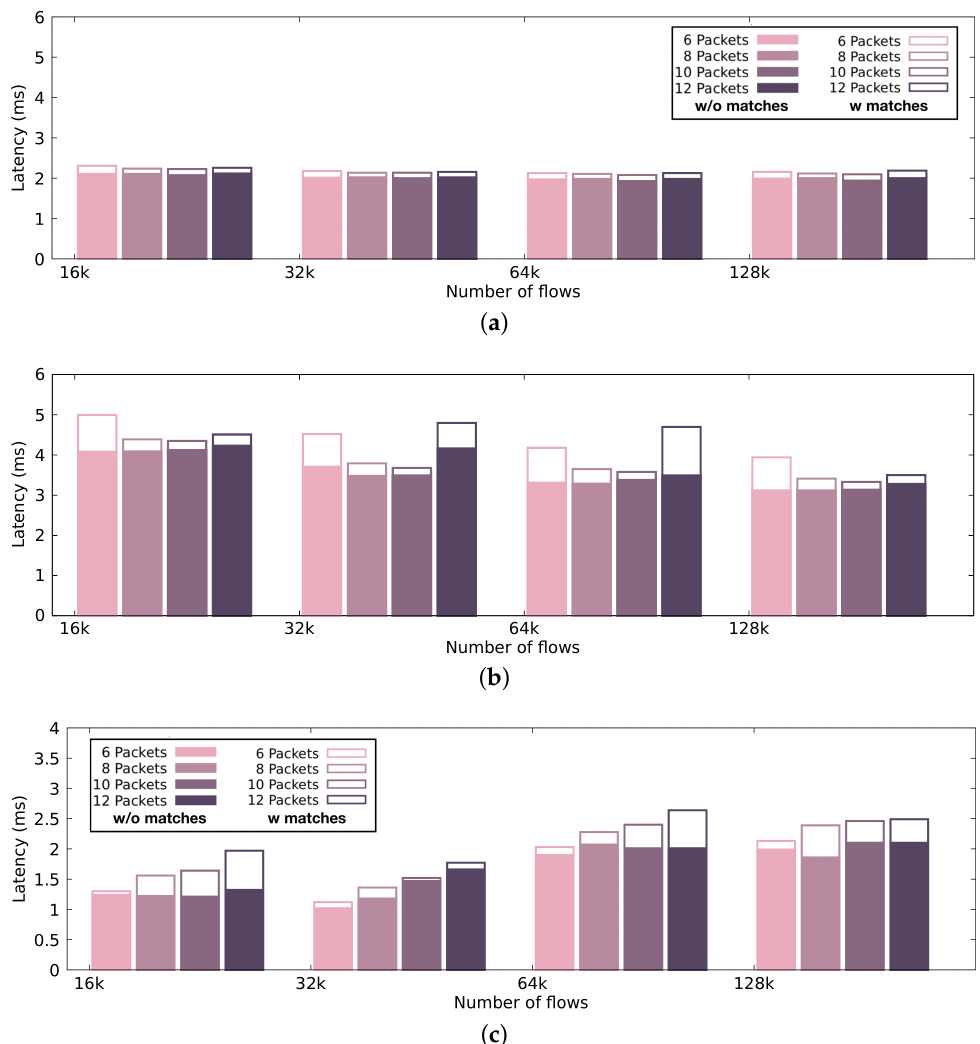
Figure 9. Latency of our pattern matching engine using a discrete GPU, an integrated GPU and a CPU. Color-filled bars indicate the performance achieved by the pattern matching engine when the selection of (i) signatures and (ii) input results in a computationally relaxed condition (i.e., less than 10% malicious traffic), while the white-filled bars with borders indicate the performance achieved in a computationally loaded condition (i.e., 100% malicious traffic). ( a ) Latency of the intrusion detection engine using the discrete GPU.; ( b ) Latency of the intrusion detection engine using the integrated GPU.; ( c ) Latency of the intrusion detection engine using the